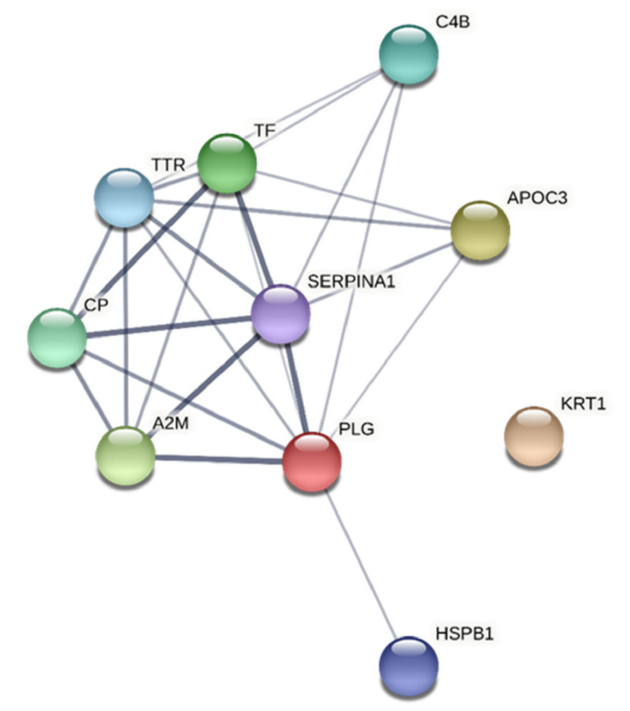
Figure 2. Network analyses of important proteins for CPT in CON. The network had the fol- lowing characteristics: number of nodes: 10; number of edges: 24; average node degree: 4.8; avg. local clustering coefficient: 0.786; expected number of edges: 1; PPI enrichment p -value: <1.0 × 10 − 16 . PLG = plasminogen; KRT1 = keratin, type II cytoskeletal 1; APOC3 = apolipoprotein C-III; A2M = alpha-2-macroglobulin; TF = serotransferrin; CP = ceruloplasmin; C4B = complement C4-B; TTR = transthyretin; HSPB1 = heat shock protein beta-1; SERPINA1 = alpha-1-antitrypsin; CON = healthy control group; CPT = cold pain